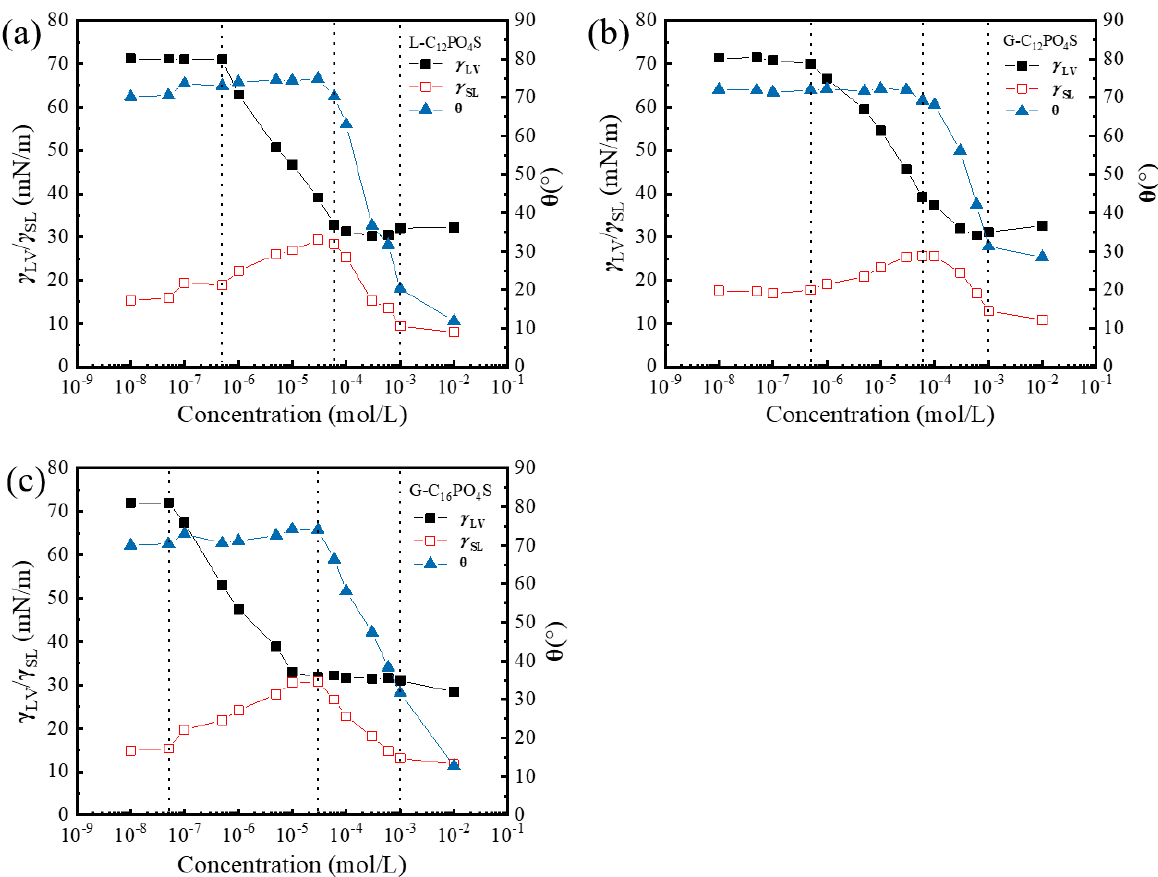
Figure 6. Concentration dependence of the adhesion data of extended surfactants L-C 12 PO 4 S ( a ), G-C 12 PO 4 S ( b ), and G-C 16 PO 4 S ( c ) on PMMA surface.